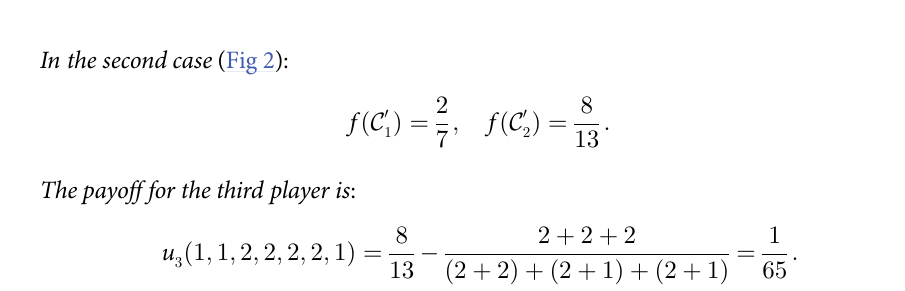
Fig 2. The communities C 0 2, 2, 2, 1).